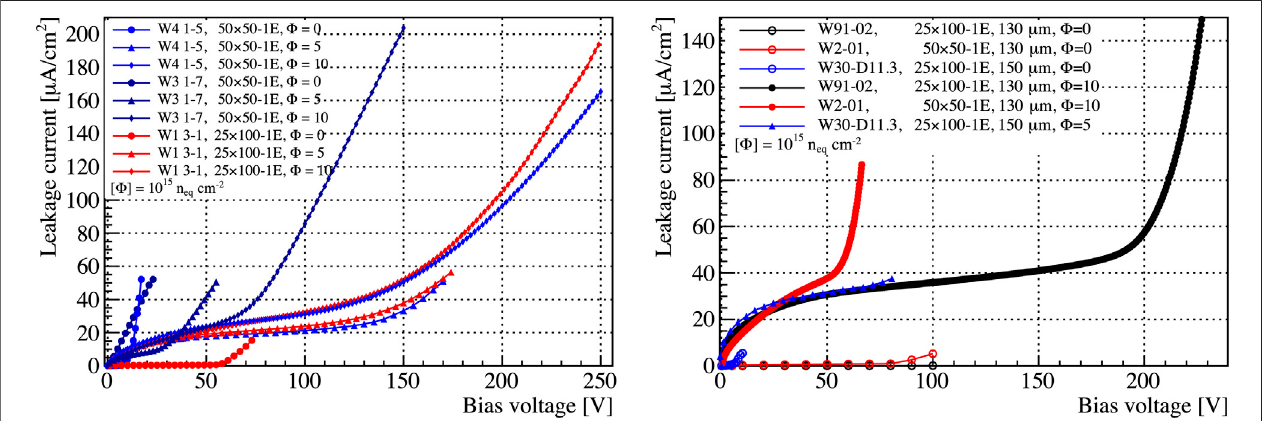
FIGURE 7 | I-V curves of RD53A modules before and after irradiation. On the left modules assembled with 3D sensors from the CNM run 9761. On the right modules assembled with 3D sensors of the FBK second and third batches.